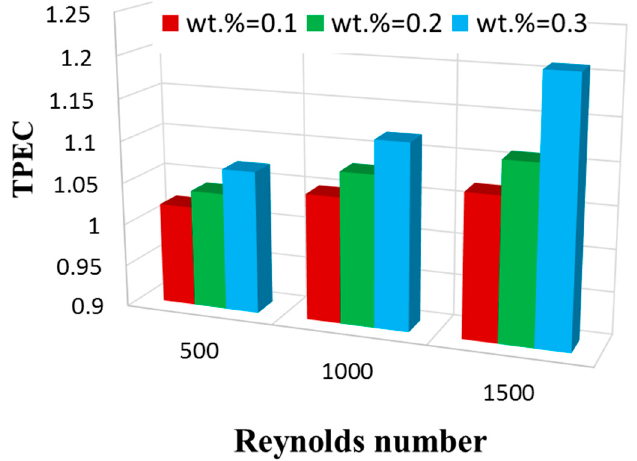
Figure 8. Variation of the thermal performance evaluation criteria (TPEC) with Reynolds number (Re) for nanofluids at various mass fractions.